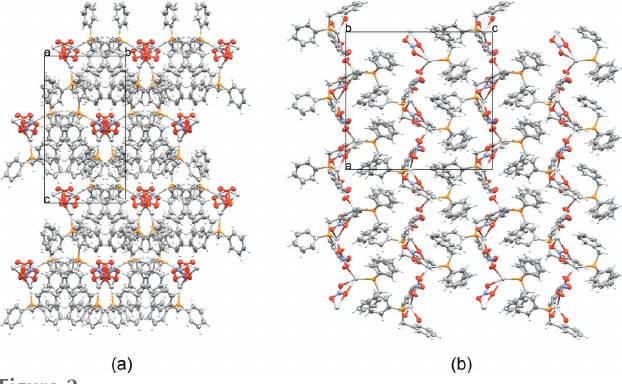
Figure 2 Perspective views along the ( a ) a and ( b ) b axes of the molecular packing of the title compound.